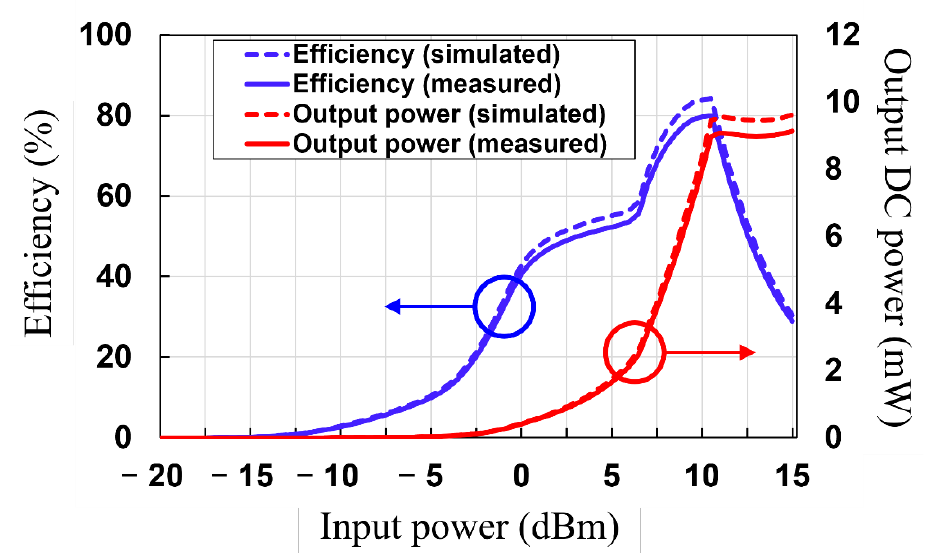
Figure 12. Simulated and measured return loss results of the rectifier